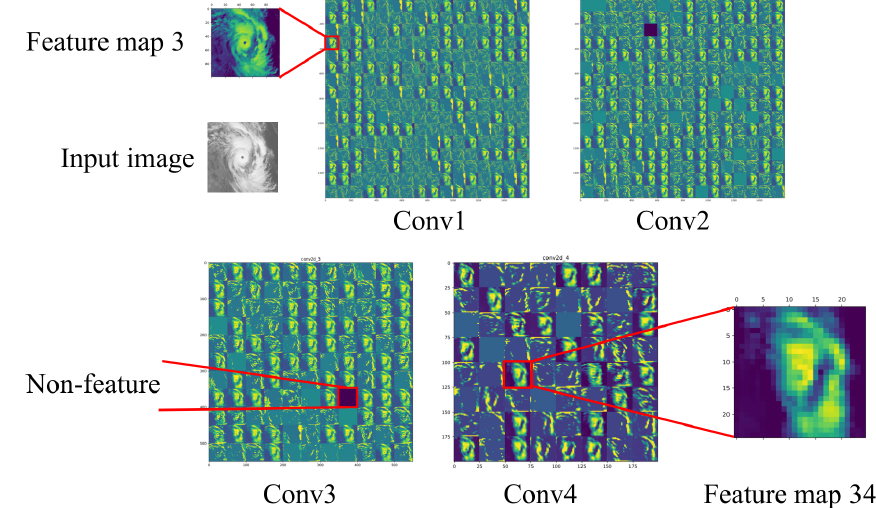
Figure 4. Visualization of outputs from the convolution kernels involved in the first four convolutional layers of a DCNN model.